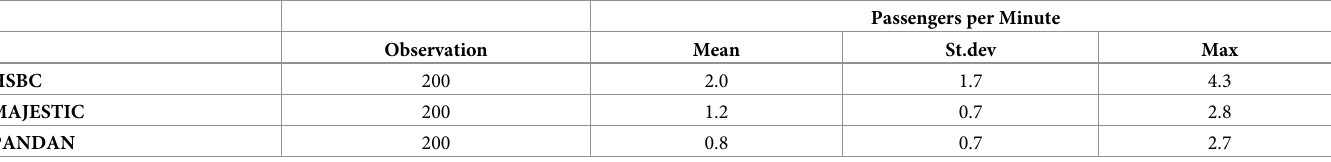
Table 6. Passenger arrival rate per minute for Route U32, AM peak,